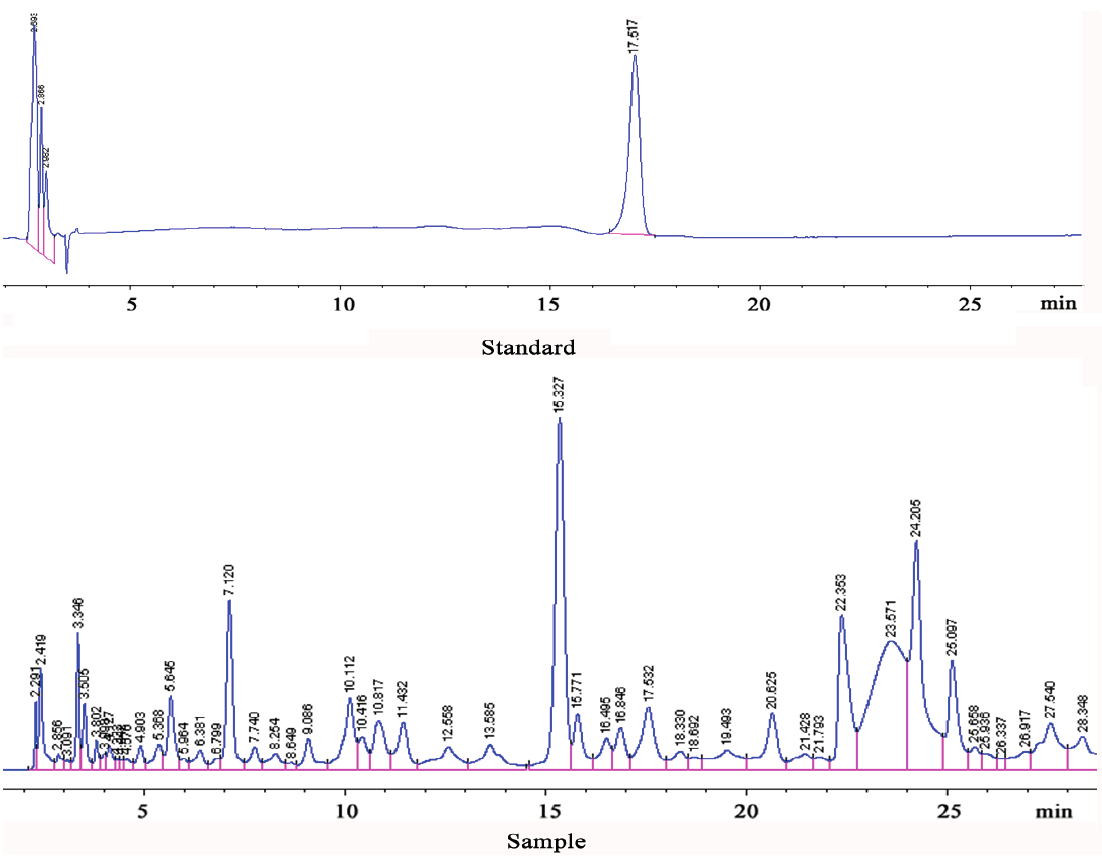
Figure 1. HPLC chromatograms of proanthocyanidins B 2 in L. ruthenicum